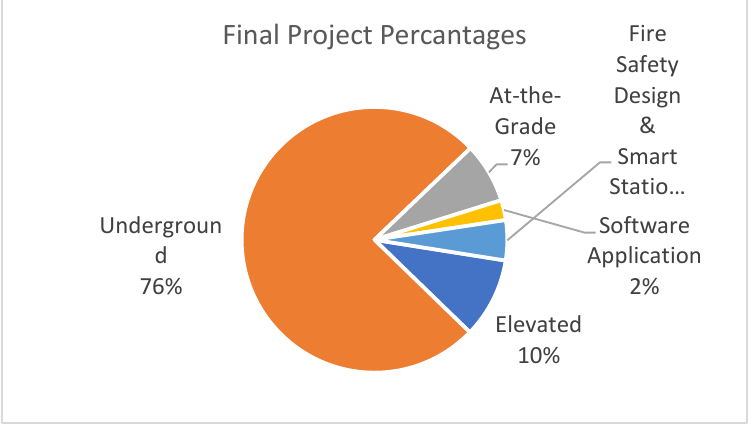
Figure 7 Percentiles of submitted projects and their typology